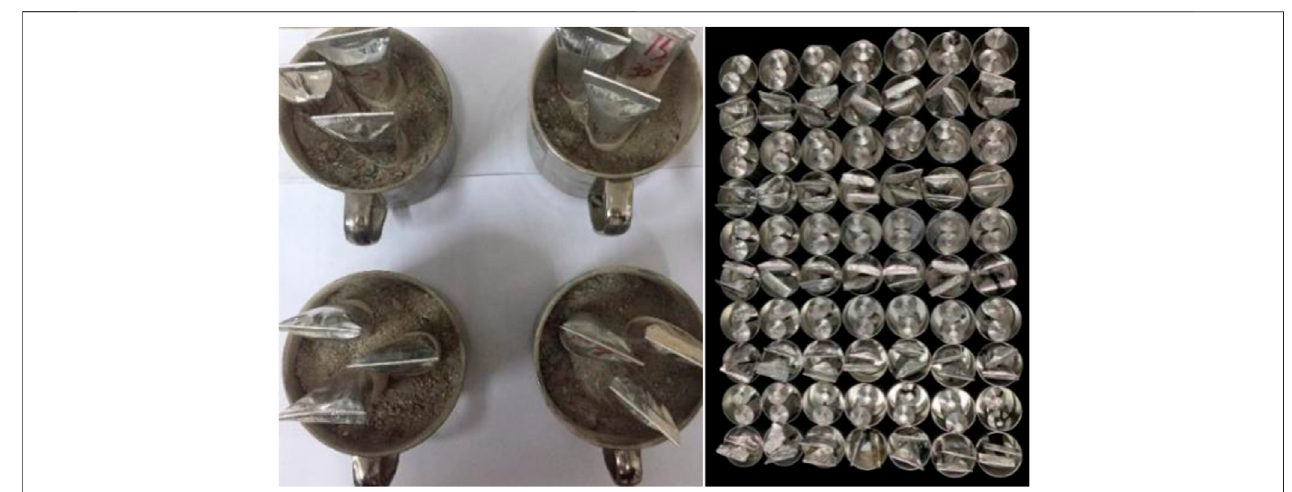
FIGURE 1 | Segregation